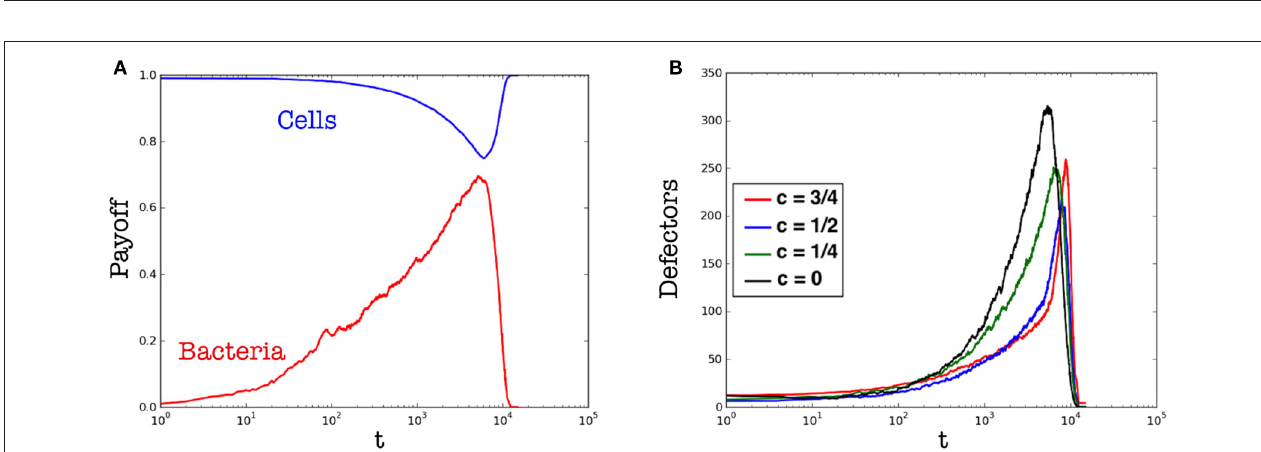
FIGURE 6 | Average magnetization of the population over time. The inset shows the heating processes applied to the system. Results are averaged over different runs.